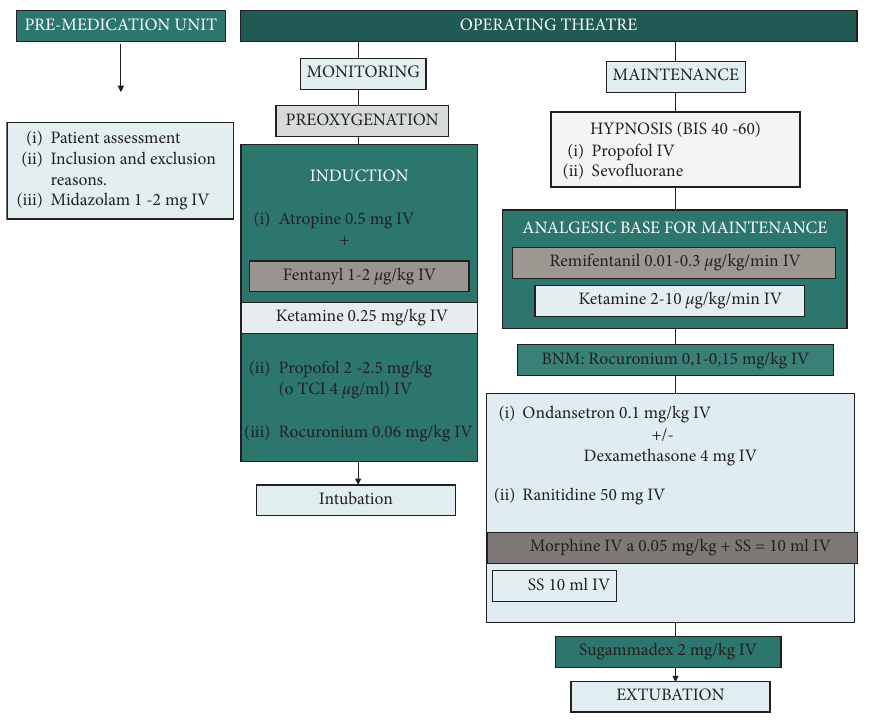
Figure 1: Anesthetic technique